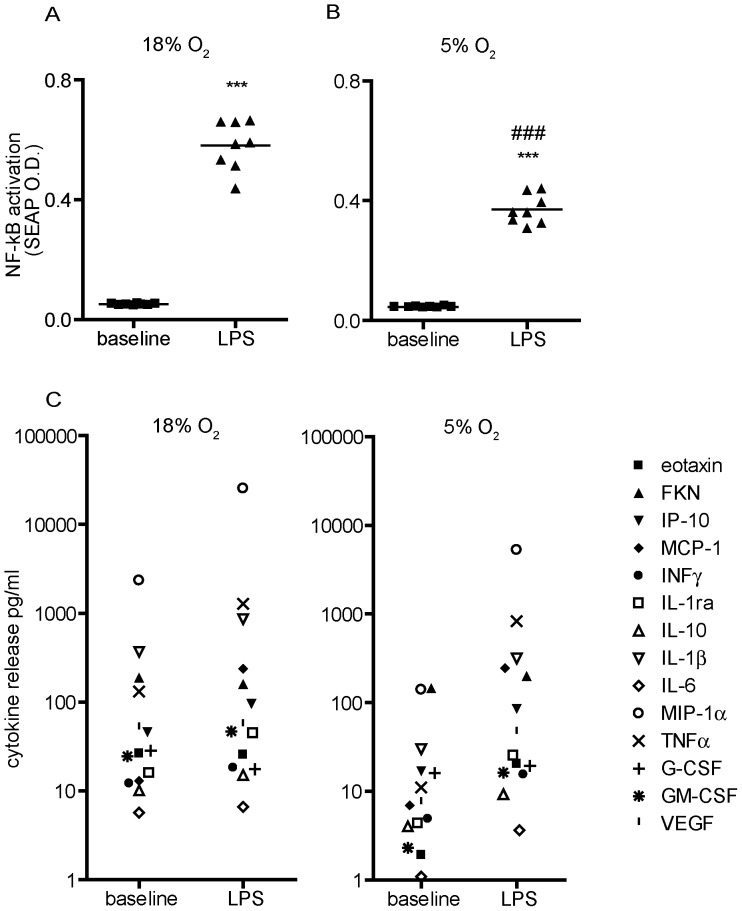
Oxygen tension influences LPS-induced NF-κB activation and release of cytokines in PMA-differentiated THP-1 cells.Undifferentiated THP-1 XBlue cells, which express an NF-κB reporter gene linked to secreted embryonic alkaline phosphatase (SEAP) were synchronized by serum deprivation for 48 h, and then differentiated with PMA (20 ng/ml) for 48 h in the absence of 2-ME and FBS. Differentiated THP-1 XBlue cells were then cultured in the absence (baseline) or presence of LPS (1 µg/ml) for an additional 24 h in either 18% (A, C) or 5% (B, D) O2. SEAP activity was quantified by QuantiBlue at 630 nm (A,B). Conditioned media from these cultures were analyzed using a human Milliplex Kit® to simultaneously quantify multiple cytokines and chemokines released from differentiated THP-1 cell during the 24 h incubation. Each symbol in panels C and D represents the mean of duplicates from one of five wells run in a representative experiment. Data are presented as the mean ± SEM (n = 2 independent experiments). ***Significantly different from baseline under the same oxygen tension at p<0.001, ###significantly different from 18% O2 at p<0.001 (Student’s t-test).